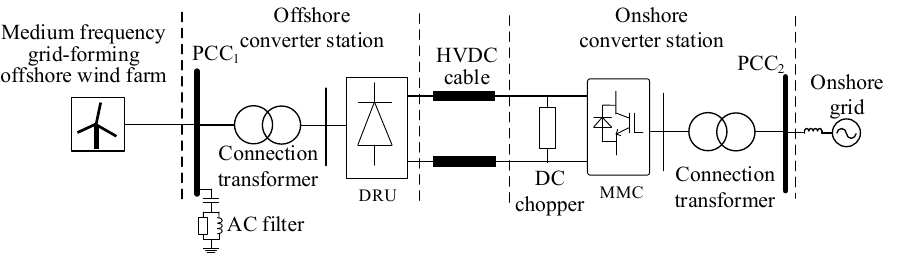
Figure 8. Scheme 6: HVDC transmission scheme for medium-frequency grid-forming offshore wind farms .